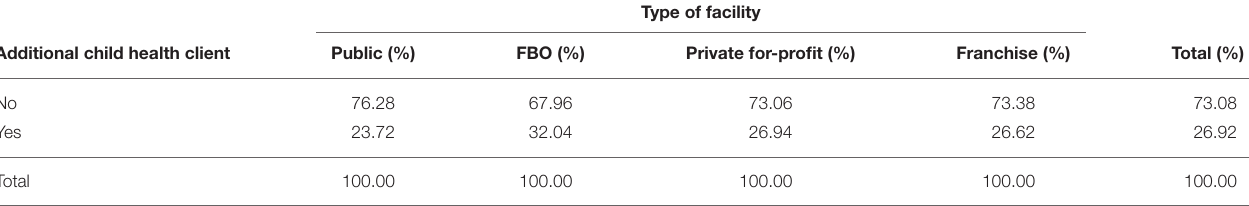
TABLE 8 | Proportion of Additional Child Health Clients, by